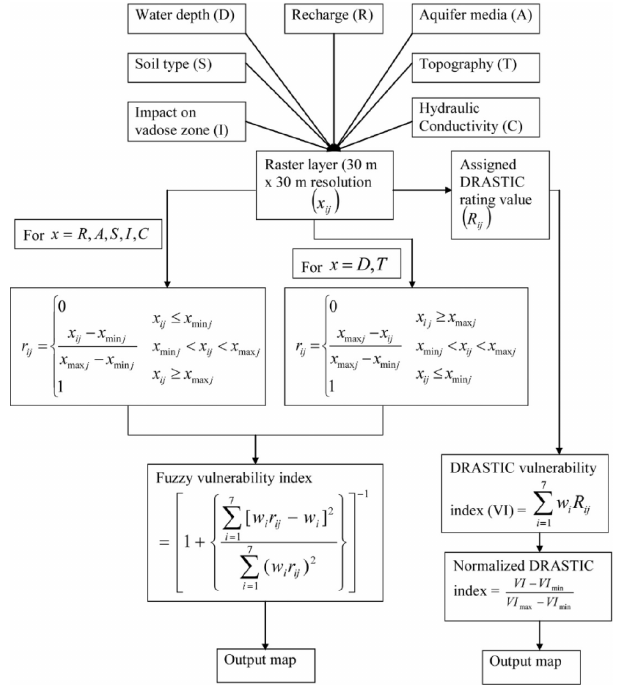
Figure 8. Flow chart of methodology adopted to develop the groundwater contamination potential map using DRASTIC and fuzzy pattern recognition models in the framework of GIS (source Pathak et al.,